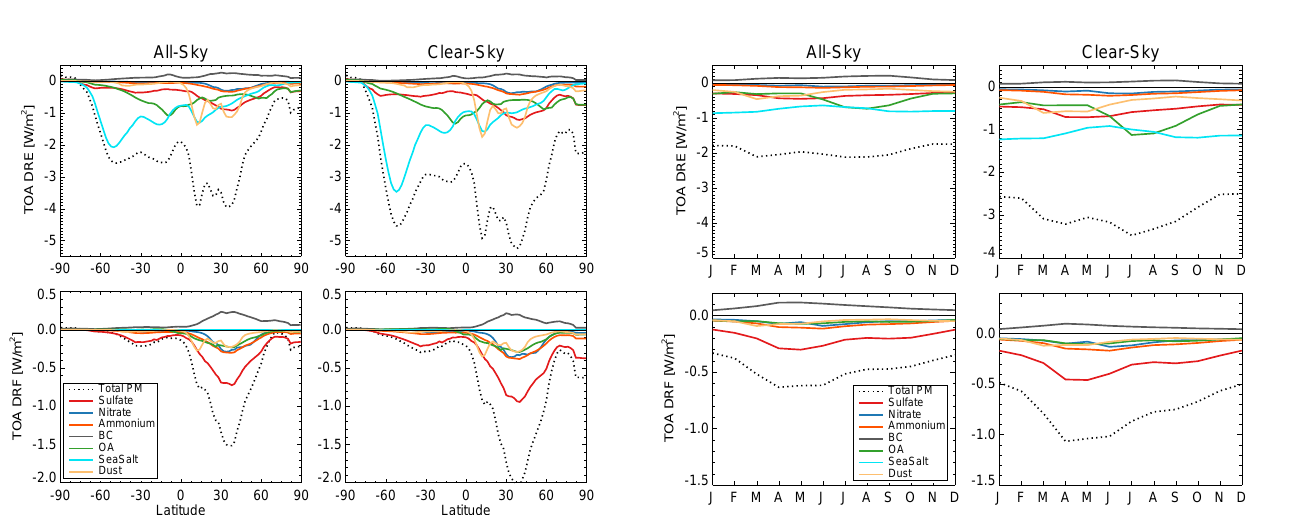
Figure 4. Global zonal mean speciated aerosol TOA direct radiative effect (top) and direct radiative forcing (bottom) for all-sky (left) and clear-sky (right) simulated by GC–RT for 2010.